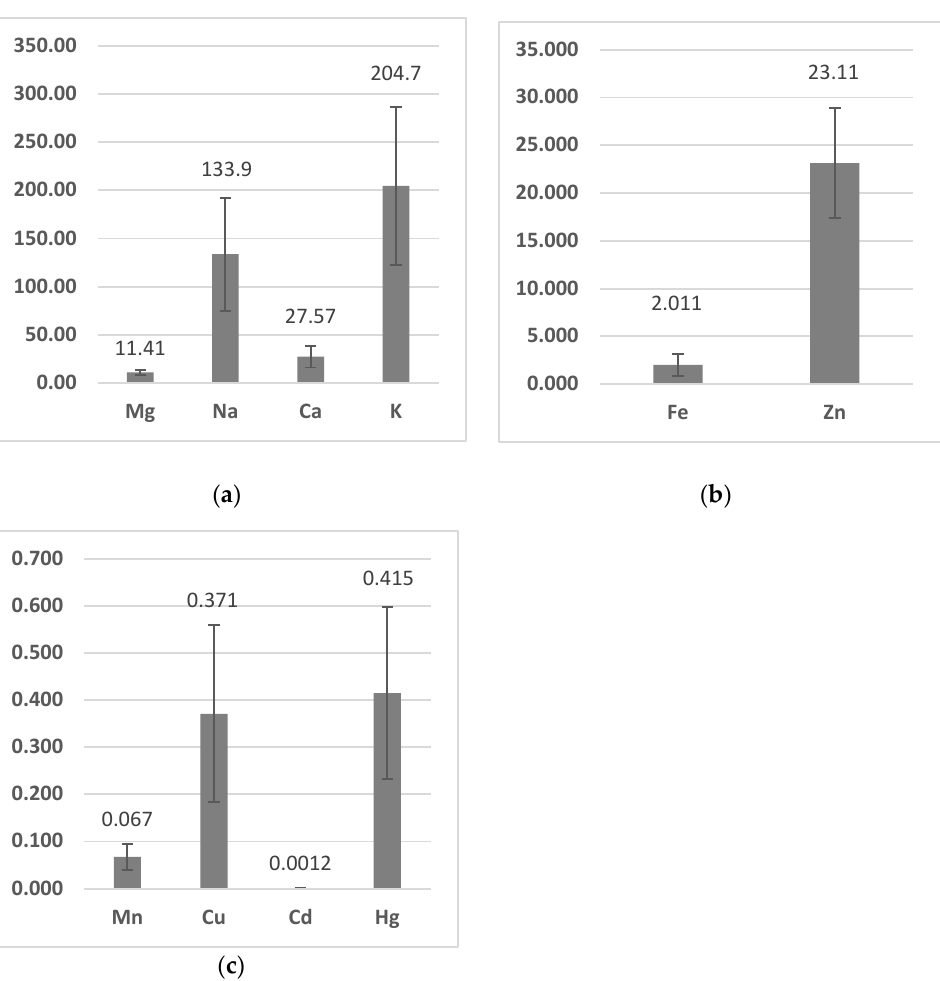
Figure 1. The content of metals (±standard deviation) ( a ) Mg, Na, Ca and K (mg/100 wet weight), ( b ) Fe and Zn (mg/kg wet weight), ( c ) Mn, Cu, Cd and Hg (mg/kg wet weight) in muscles of the European eel ( Anguilla anguilla L.).